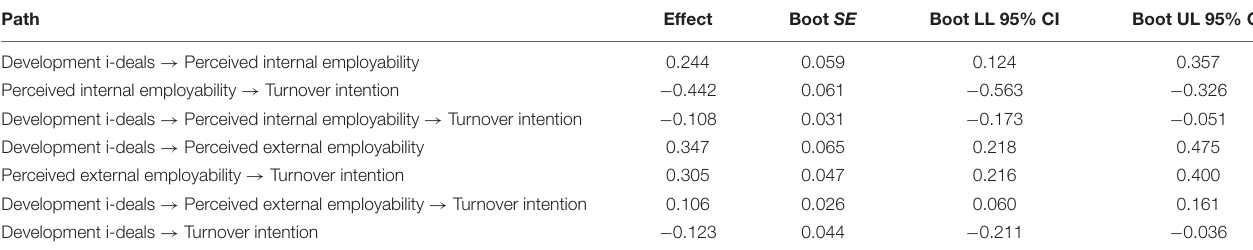
TABLE 3 | Bootstrapping results for mediation relationship tests.